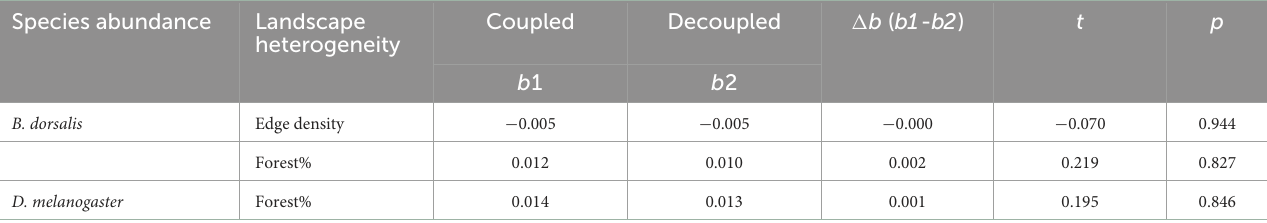
TABLE 1 Grouped regression results show differences in the fitting linear relationship between landscape heterogeneity with pests from spatial coupled to decoupled. Species